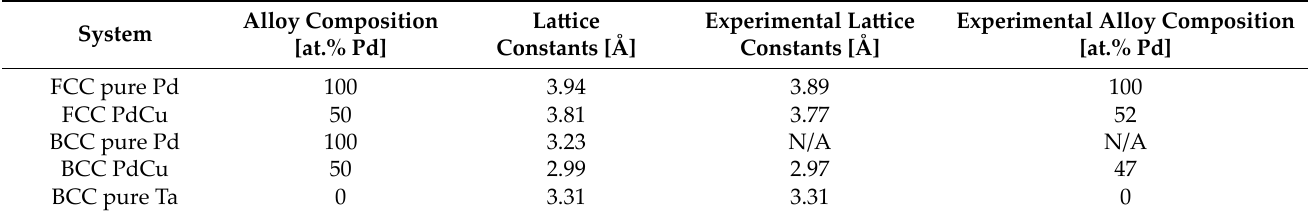
Table 1. Estimates of lattice constants and comparison with experimental values in [42–44] for